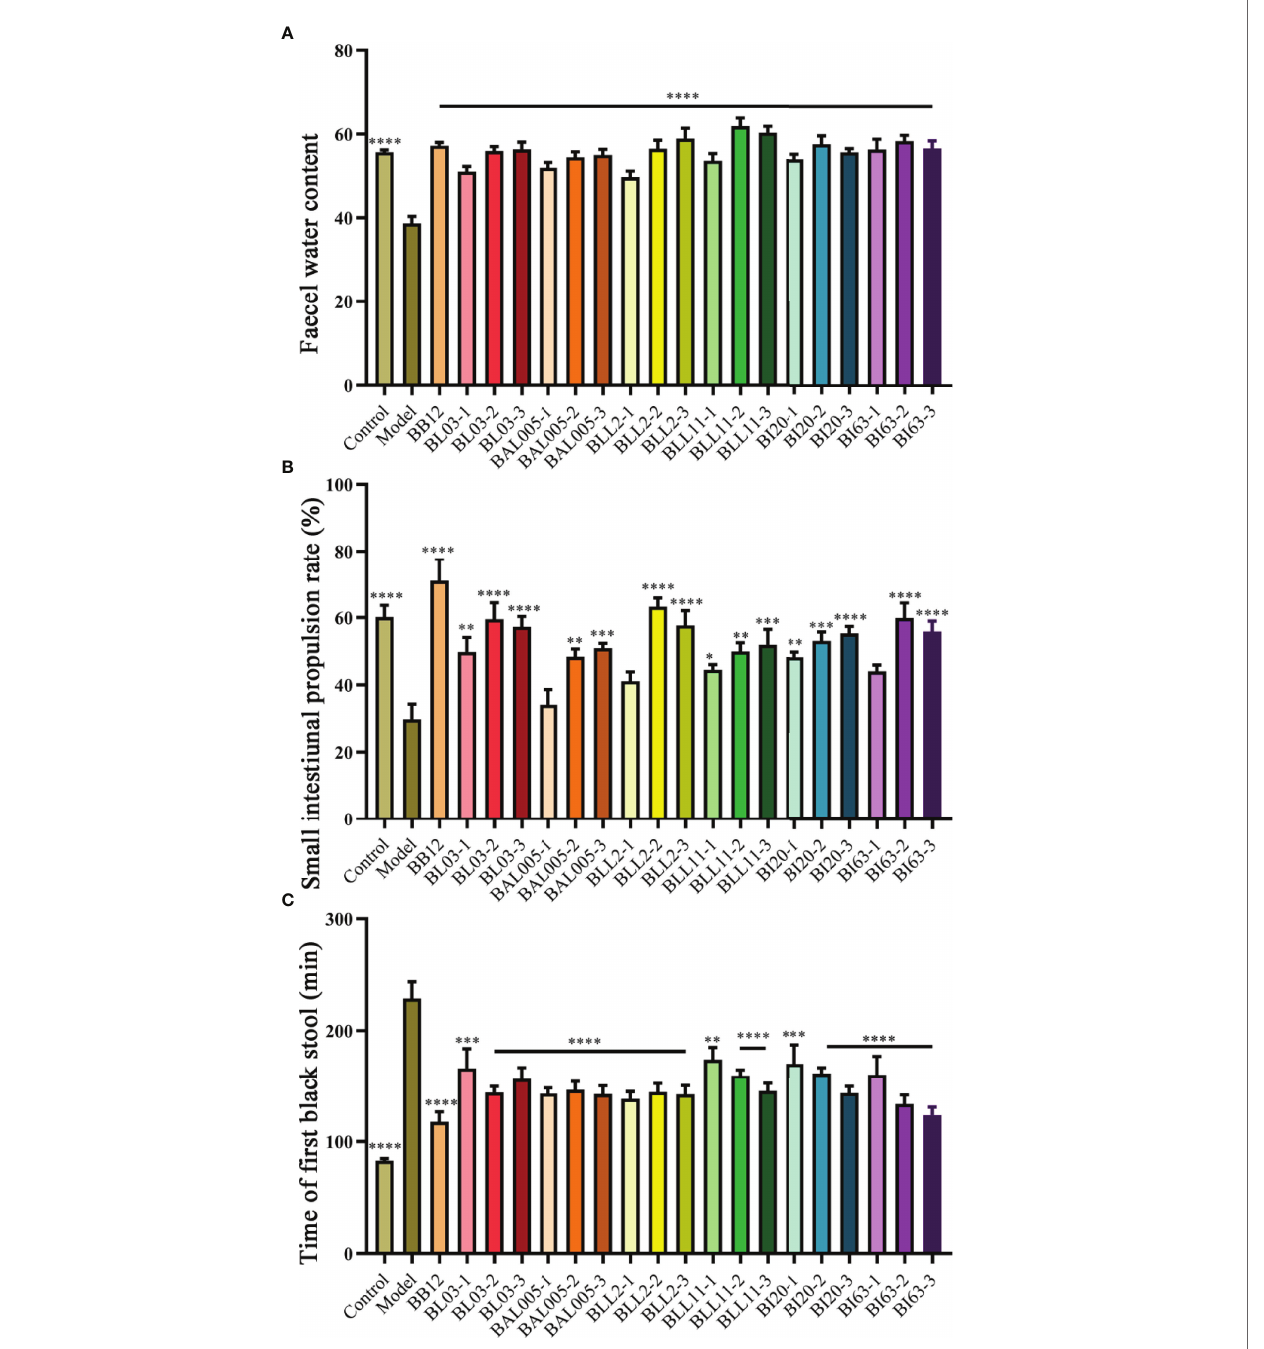
FIGURE 1 | Defecation-related parameters. Fecal water content (A) . Small intestinal propulsion rate (B) . Time of fi rst black stool (C) . There is a signi fi cant difference between the bacteria intervention group and the model group, where * means P < 0.05, **P < 0.01, ***P < 0.005, ****P <